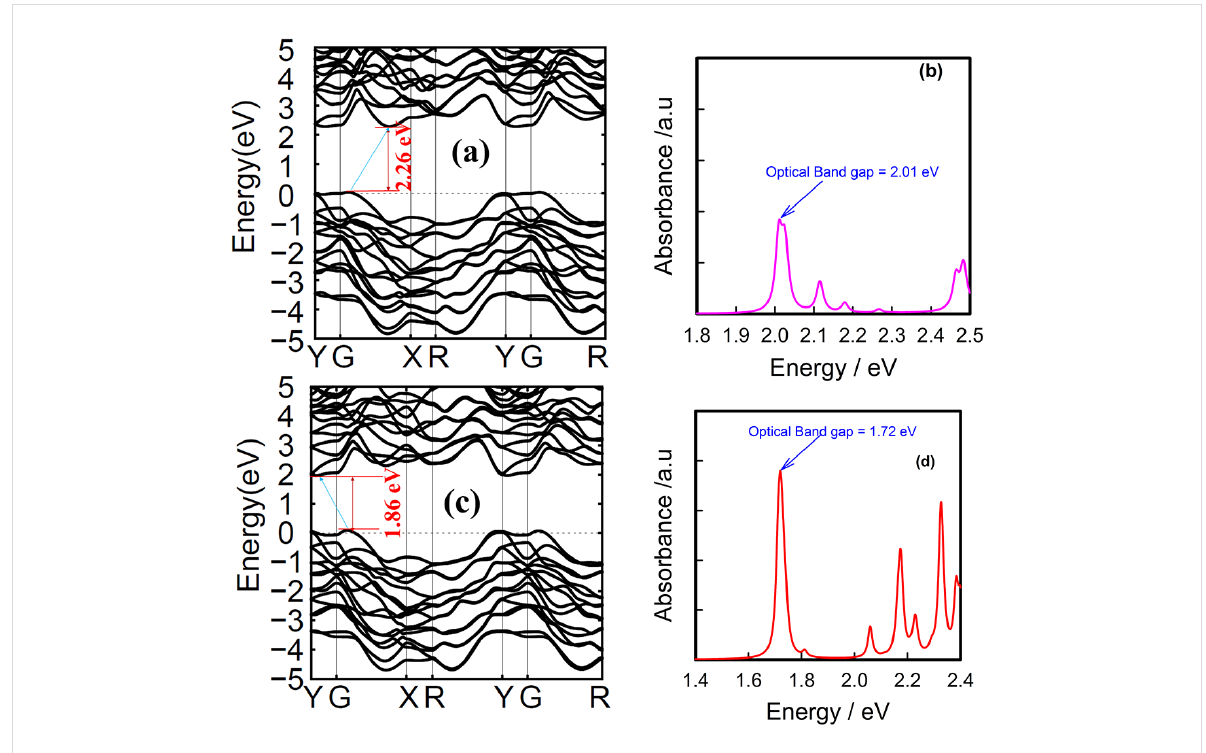
Figure 5: (a,c) GW-band structures and (b,d) BSE-optical absorption spectra of SiAs 2 and GeAs 2 ,